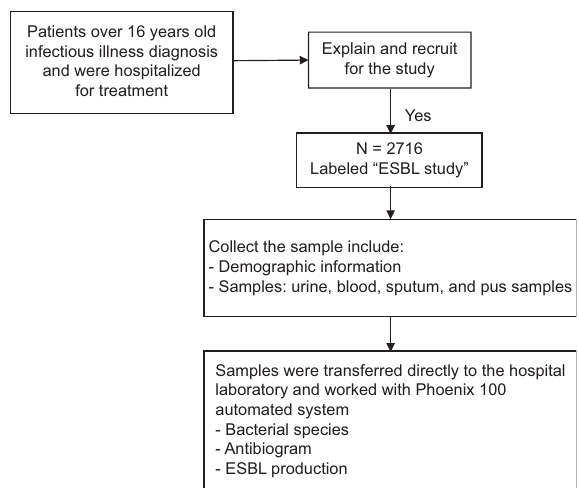
FIGURE 1. Schema of data